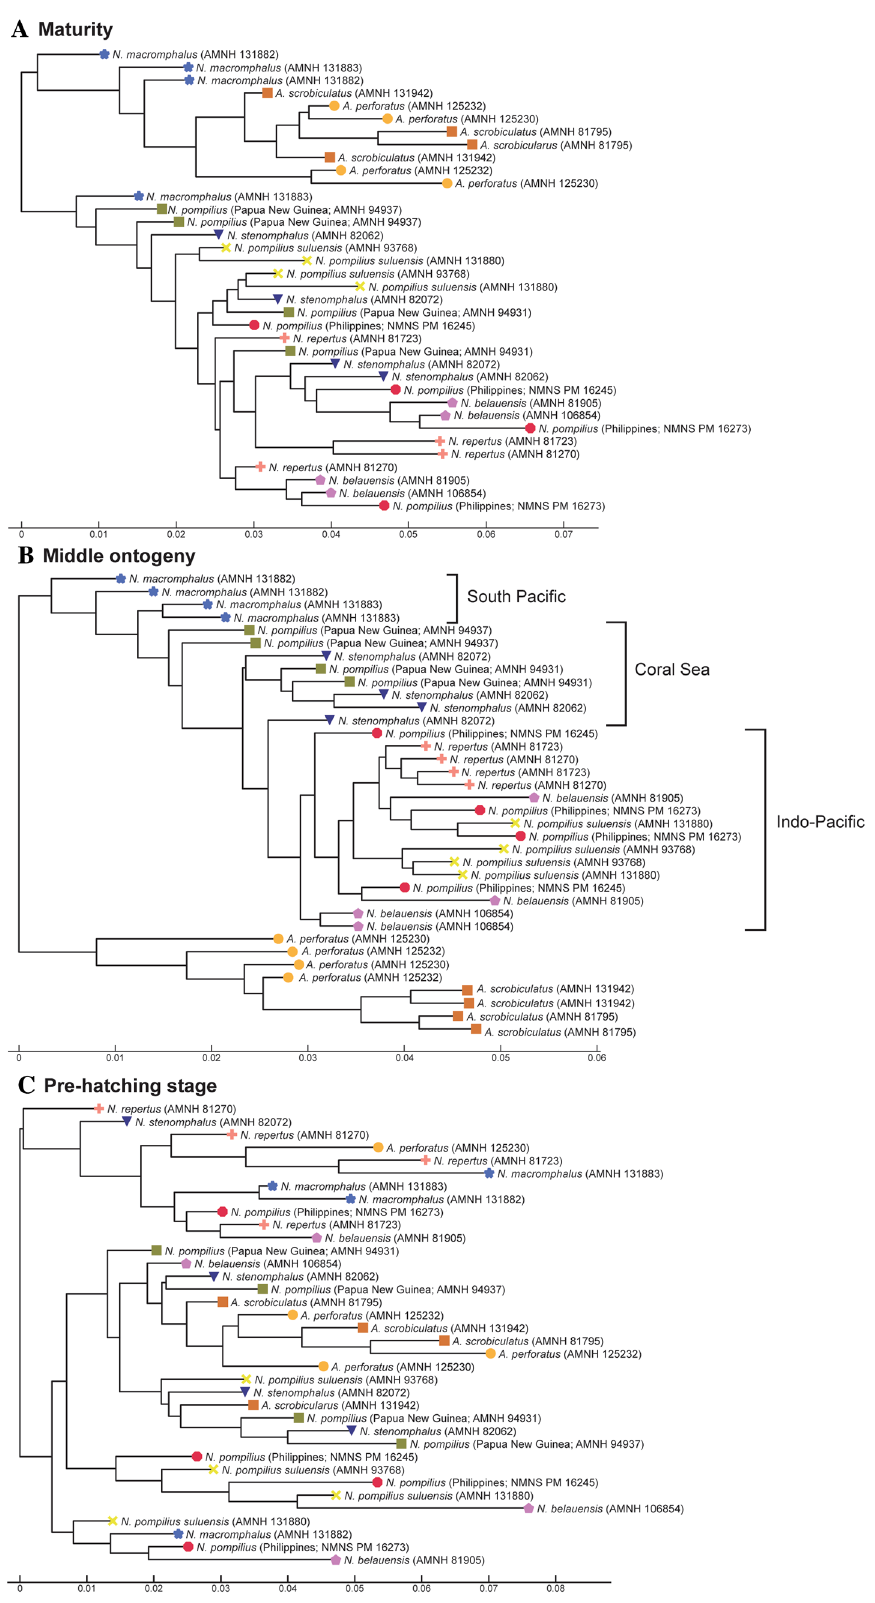
Figure 5. Trees for conch geometry (cross-sectional morphology). ( A ) Maturity (last two chambers). ( B ) Middle ontogeny (a diameter of about 50 mm). ( C ) Pre-hatching stage (a diameter of about 20